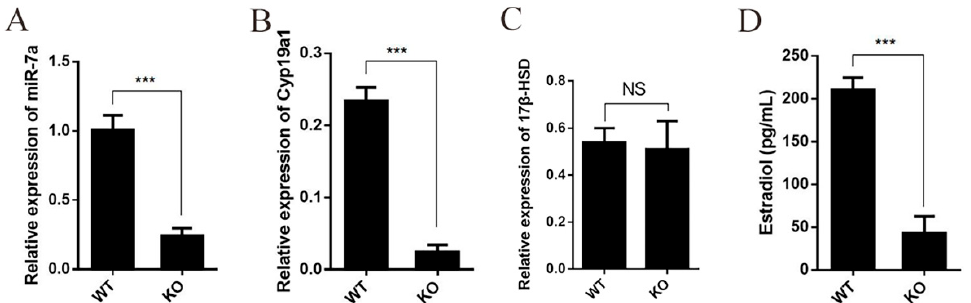
Figure 3. MiR-7a2 deficiency reduces estrogen synthesis in vitro. ( A ) The KO efficiency of miR-7a2 in primary granulosa cells. ( B ) The expression of Cyp19a1 in primary granulosa cells of WT and KO mice. ( C ) The expression of 17 β -HSD in primary granulosa cells of WT and KO mice; n = 4. ( D ) Concentrations of E 2 in culture medium. *** p < 0.001. NS, not significant.